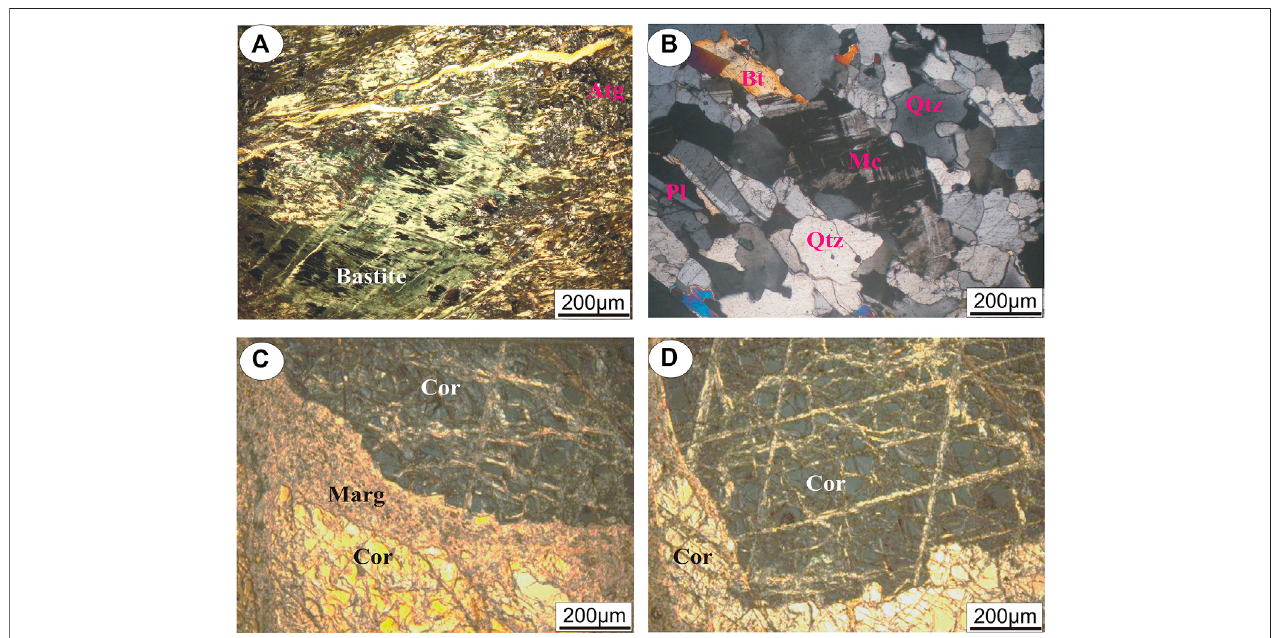
FIGURE 7 | (A) Microveinlets of carbonates intersected antigorite (Atg); (B) Anhedral microcline (Mc) crystal corroded by quartz (Qtz) and plagioclase (Pl); (C,D) Margarite (Marg) between high relief anhedral and fractured corundum (Cor).